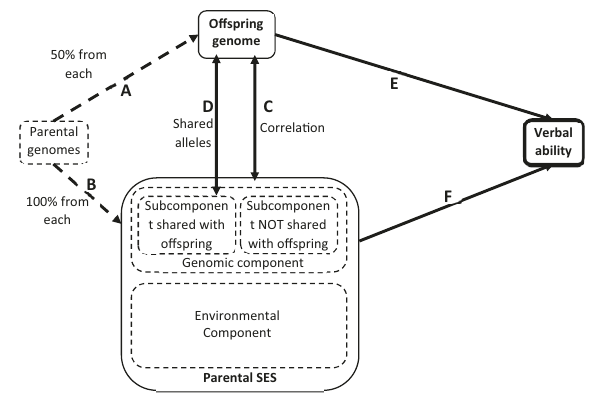
Fig. 1 Conceptual model of how parental genome, parental SES and offspring genome in fl uence verbal ability. (An arrowed line indicates a causal effect; a double-arrowed line indicates a correlation. Solid lines represent observed relationships while interrupted lines represent unobserved relationships ). a While offspring genome receives 50% of genetic alleles from each parent ’ s genome randomly (path A), parental SES is subject to the in fl uence of all parental alleles (100% from each parent, (path B). b Offspring genome and parental SES are correlated (path C) due to the shared alleles between offspring genome and the subcomponent of the genomic component in parental SES (path D). c The same set of alleles from offspring and parents act on the subcomponent shared between parents and offspring; the subcomponent not shared with offspring is only acted upon by parental alleles not transmitted to offspring. The two subcomponents are hypothesized to be about the same. d In regression of verbal ability, the effects of offspring genome and parental SES are expected to be reduced because of the correlation. e The size of reduction in the offspring-genome effect may re fl ect the size of an overestimate in a regression in which parental SES is not included. f The effect of parental SES is reduced because the inclusion of offspring genome removes about one half of the entire genomic component in parental SES. The total size of the genetic component in parental SES is reasoned to be about twice as large as the reduction in the effect of parental SES when offspring genome is